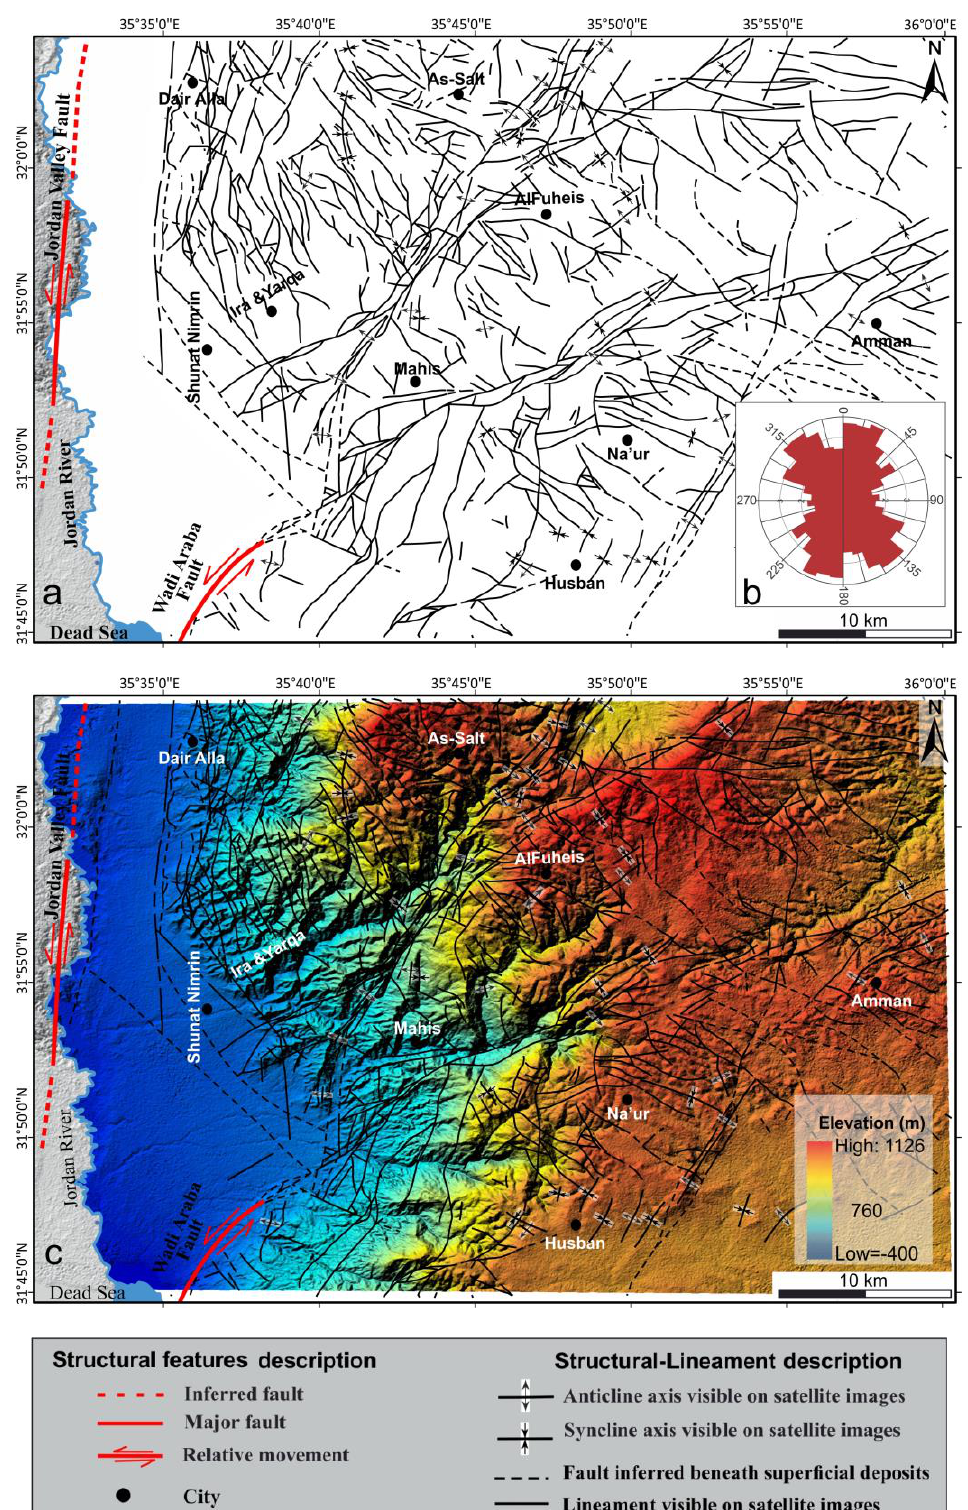
Figure 6. ( a ) Automated lineament map extracted from Landsat-8 OLI satellite images taken within the study area. ( b ) Rose diagram plot of the extracted lineaments showing two main lineament population trends based on cumulative-length weighting: NNE- SSW, NW-SE, and a minor trend NE-SW. ( c ) Extracted lineament overlay on the hill-shaded model of the study area (the red color represents a relatively higher elevation and the blue color represents a relatively lower elevation).